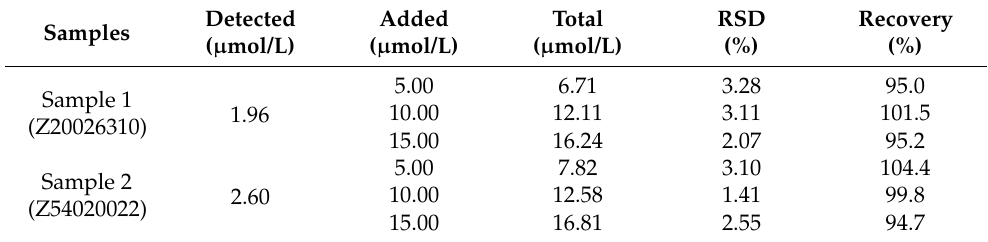
Table 1. Detection results of 6,7-DHC in real samples (n = 3).